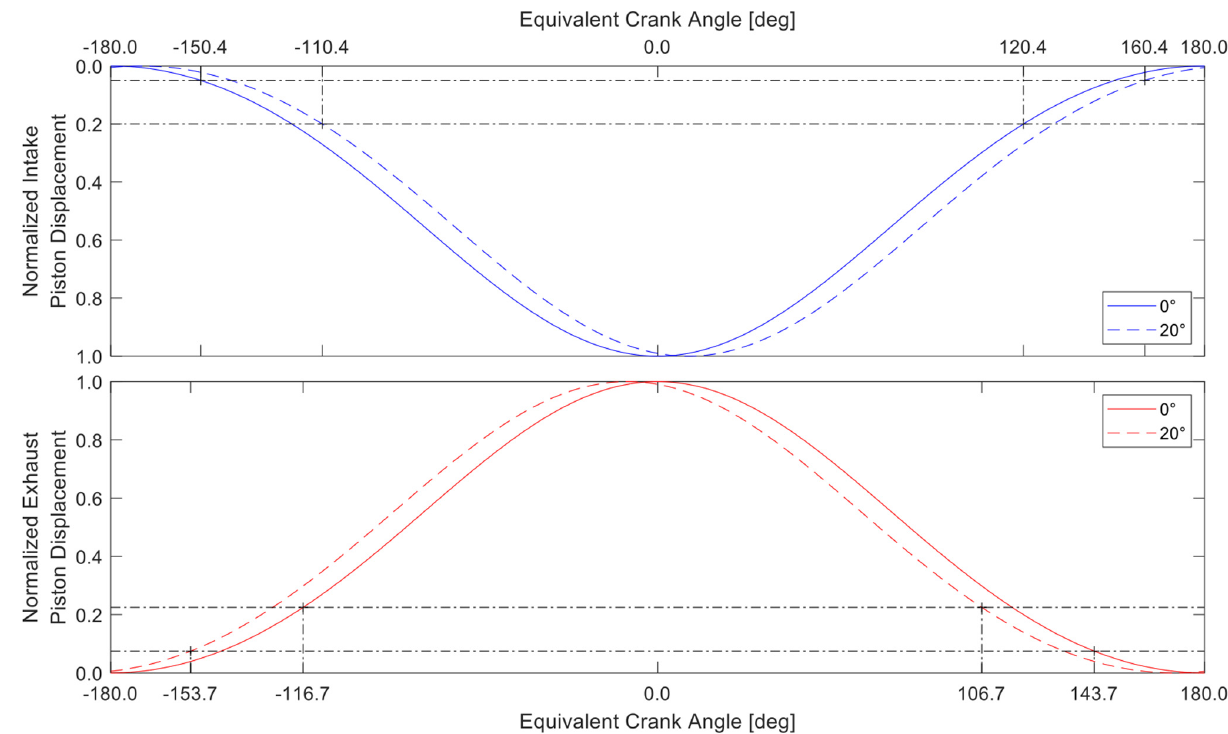
Figure 7. Normalized intake ( top , blue) and exhaust ( bottom , red) displacement profiles for 0° (minimum) and 20° (maximum) crankshaft phasing. Horizontal dash-dot lines indicate the range of port heights investigated.